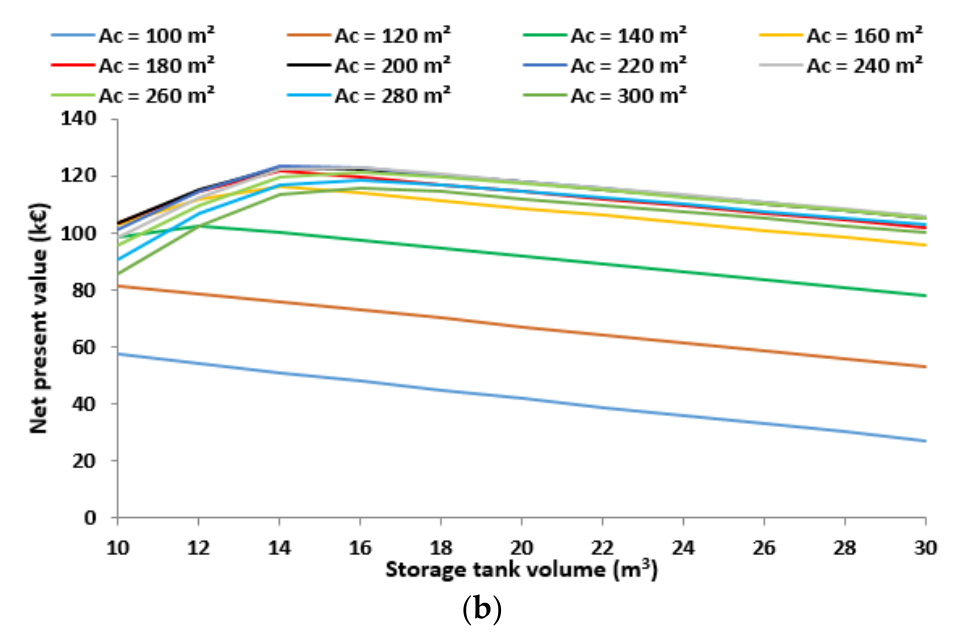
Figure 4. Net present value ( a ) for different collecting areas with the storage tank volume as the main parameter ( b ) for different storage tank volumes with the collecting area as the main parameter.